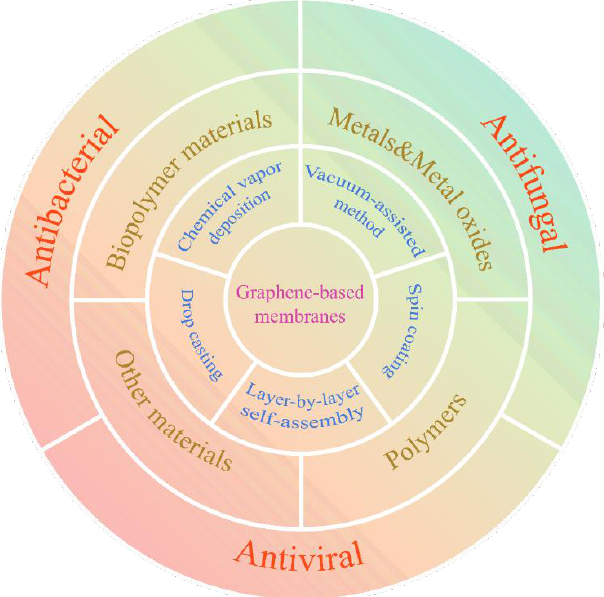
Figure 1. Schematic presentation of synthesis, functional tailoring, and antimicrobial applications of graphene-based membranes.